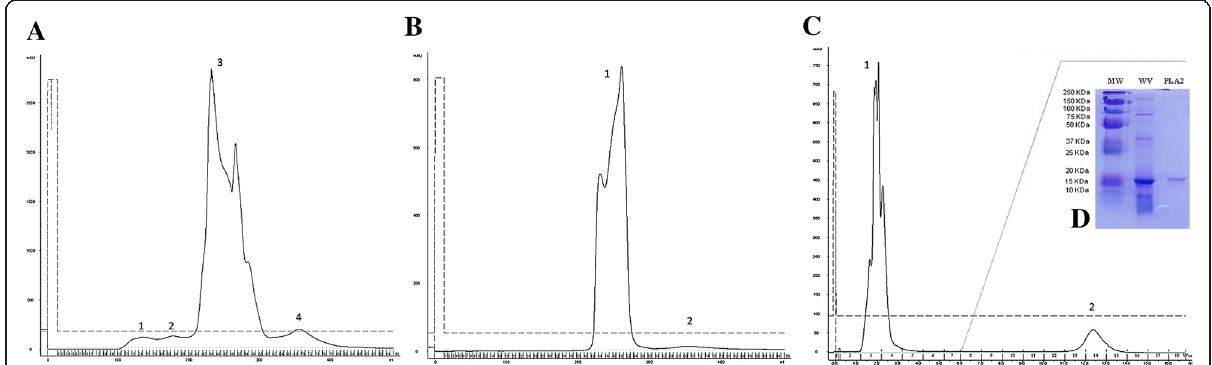
Fig. 1 a Chromatographic profile of Crotalus durissus terrificus venom by molecular exclusion technique . The peaks correspond to convulxin [1], giroxin [2], crotoxin [3] and crotamine [4]. b Chromatographic profile of crotoxin fraction of Crotalus durissus terrificus venom by molecular exclusion step. c Chromatographic profile of crotoxin fraction of Crotalus durissus venom by ion exchange step, evidencing crotapotin [1] and PLA 2 [2]. d SDS-PAGE of weight marker (WM), whole venom (WV) and PLA